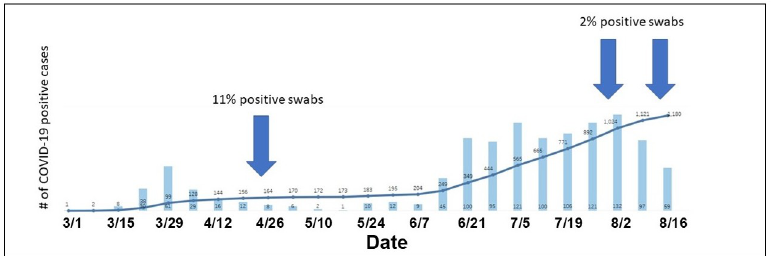
Fig 2. SARS-CoV-2 positive patients at UCDMC during the first and the second wave of COVID-19. Weekly totals of COVID-19 patients, and the cumulative total number from early March until mid-August, 2020. The blue arrows indicate the sampling